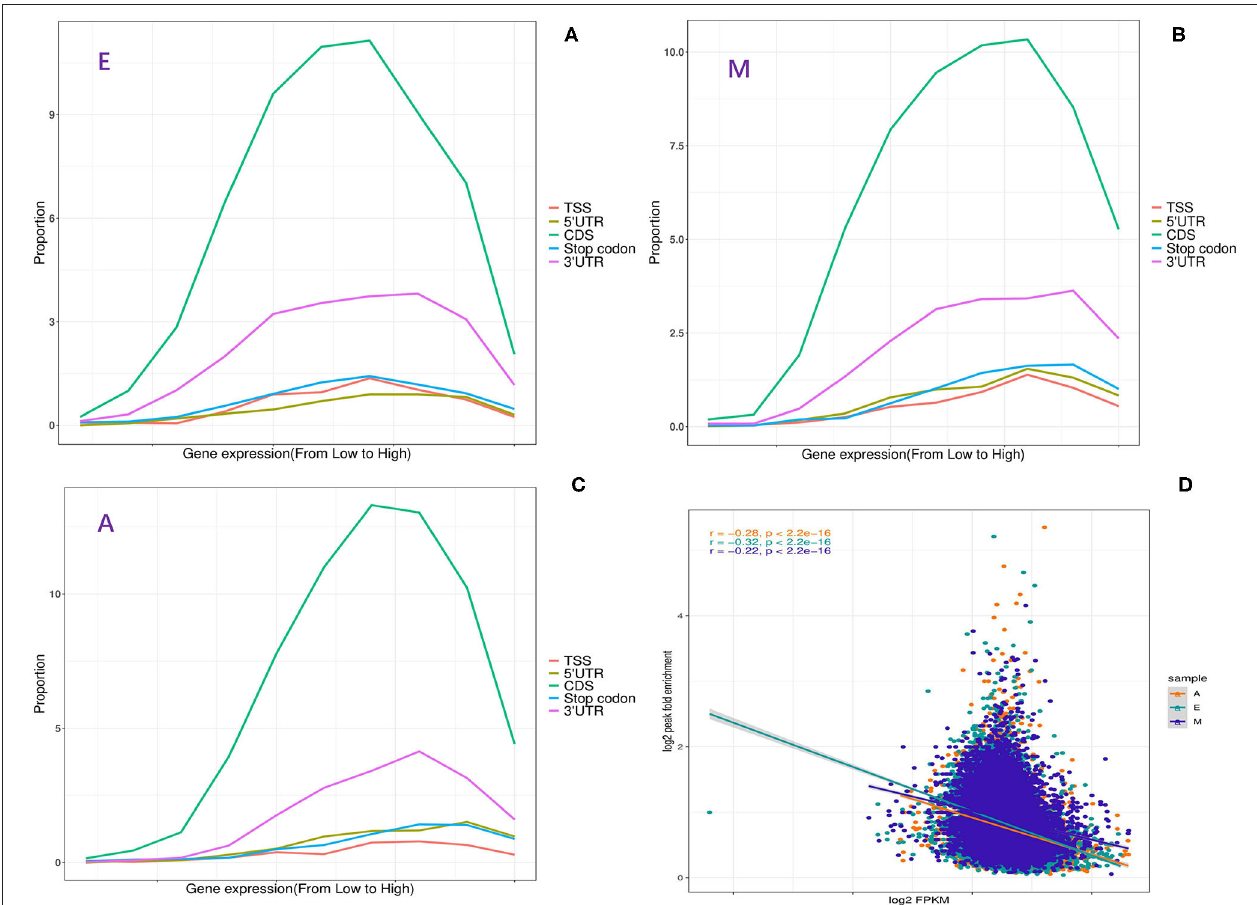
FIGURE 2 | Relationship between m6A methylation and expression of modified genes. (A–C) Fraction of genes with m6A peaks in each of the segments as a function of the expression level. (D) The plot of m6A peak enrichment and mRNA abundance in the three developmental